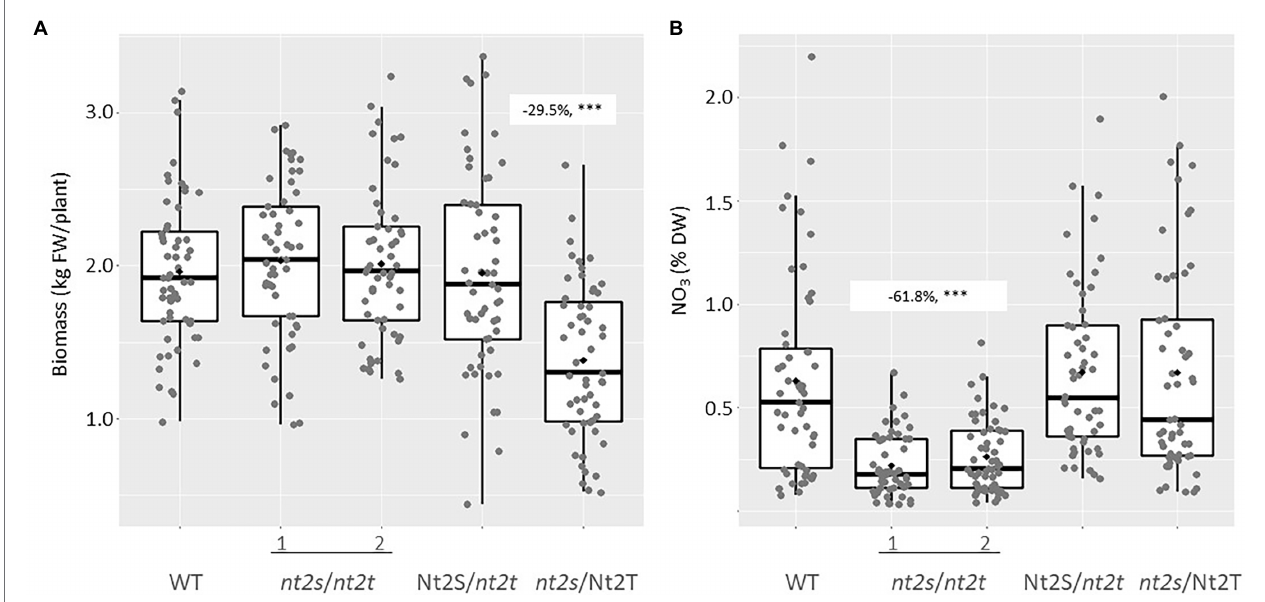
FIGURE 6 | Fresh plant biomass (A) and nitrate content (B) in the lamina of WT and clcnt2 -KO mutants. Approximately 50 plants of each genotype (WT, nt2s / nt2t genotypes 1 and 2, Nt2S/ nt2t , and nt2s /Nt2T) were weighed at harvest. After air-curing, the lamina from the fourth leaf from the top of each plant was assayed for nitrate content. The charts represent boxplots of the five genotypic groups. For biomass (A) , the maximum difference observed between the WT and nt2_s /Nt2_T plants was − 29.5% ( − 20.9, − 38.1%), p < 0.001***; for nitrate levels (B) , the difference observed between WT plants and the two nt2_s/nt2_t lines was − 61.8% ( − 44.6, − 78.9%), p < 0.001***. An ANOVA test with a CI of 90% was